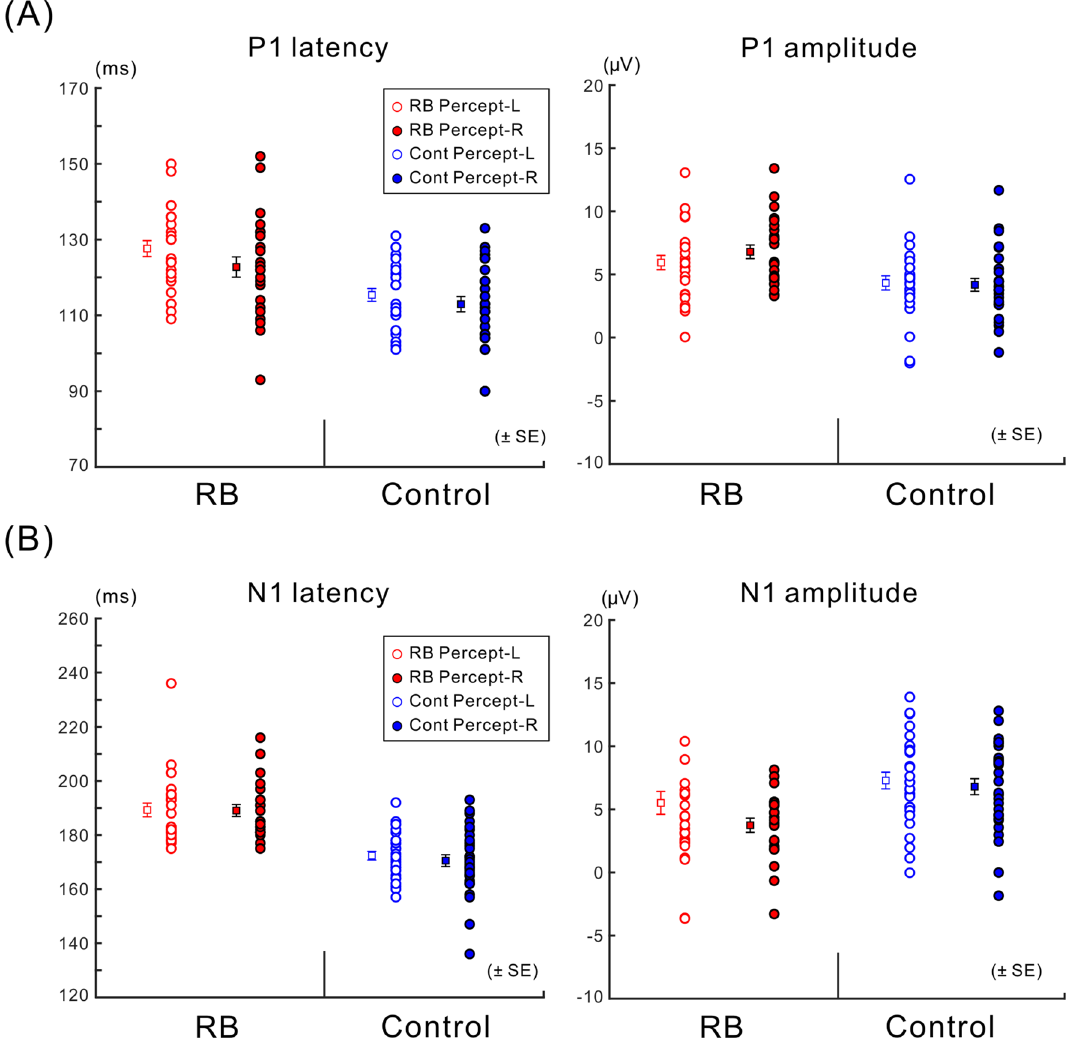
Figure 7. Latencies and amplitudes of VEPs for each percept of the Necker lattice. ( A ) Mean of peak latencies (left) and mean of peak amplitudes (absolute values) (right) for P1 with their respective means are illustrated across participants. The peak latency and peak amplitude of P1 were not significantly affected by any factor related to the experimental condition or perception toward the Necker lattice; these results thus supported that neural adaptation to the adaptor at the level of 3D lattice configuration did not affect P1 if present (see text for details). ( B ) Mean of peak latencies (left) and mean of peak amplitudes (absolute values) (right) for N1 with their respective means are illustrated across participants. The peak latency and peak amplitude of N1 were not significantly affected by any factor related to the experimental condition or perception toward the Necker lattice; these findings supported that N1 was not confounded by the neural adaptation at the level of 3D lattice representation or RN (reversal negativity, a negative-going VEP component related to the perceptual alternation of a bistable stimulus) if either or both were present (see text for